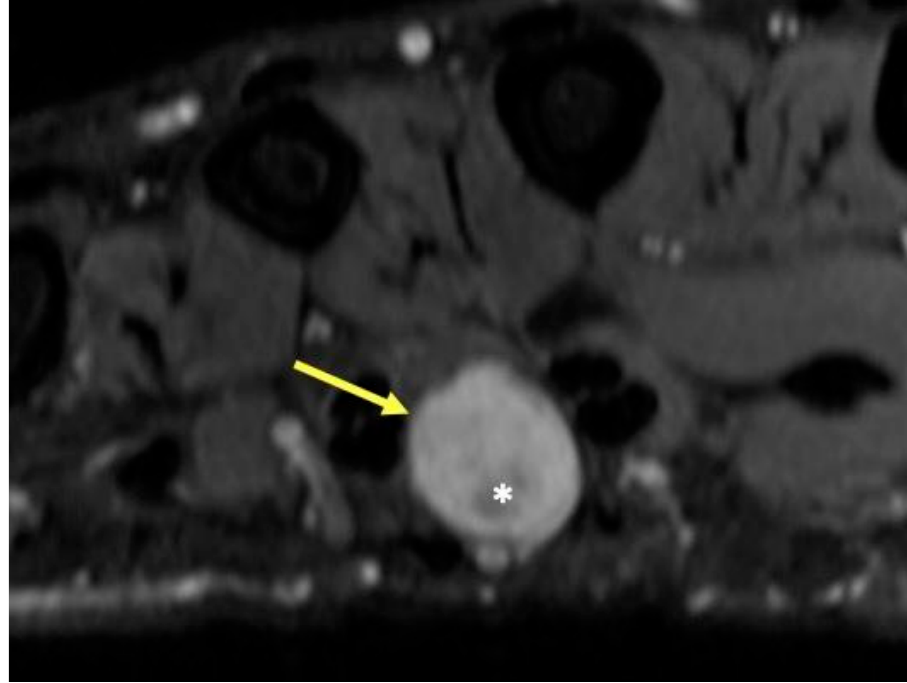
Figure 6. Patient with neurofibromatosis type II and mass in the third webspace of the hand. T2-weighted axial image showing a round hyperintense mass (arrow) with a central region of low signal intensity (*), characteristic of peripheral nerve sheath tumor, in this case a schwannoma of the common digital nerve. The hypointense central portion in T2-weighted images is attributable to a dense area of collagenous stroma; when this collagenous region is larger, the mass may assume a “target sign” appearance.